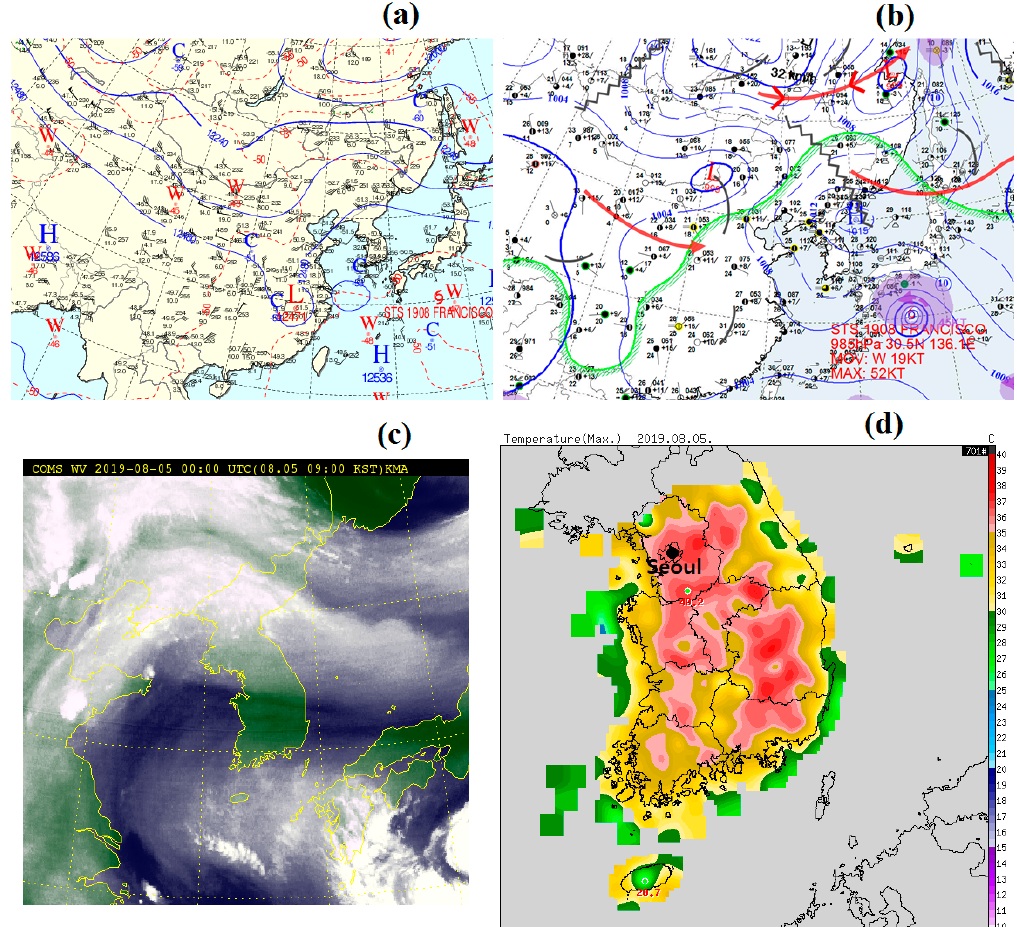
Figure 5. ( a ) 200 hPa and ( b ) surface weather chart, and ( c ) Communication, Oceanic and Meteorological Satellite (COMS) water vapor image at 0000 UTC, and ( d ) spatial distribution of daily maximum air temperatures on 5 August 2019.